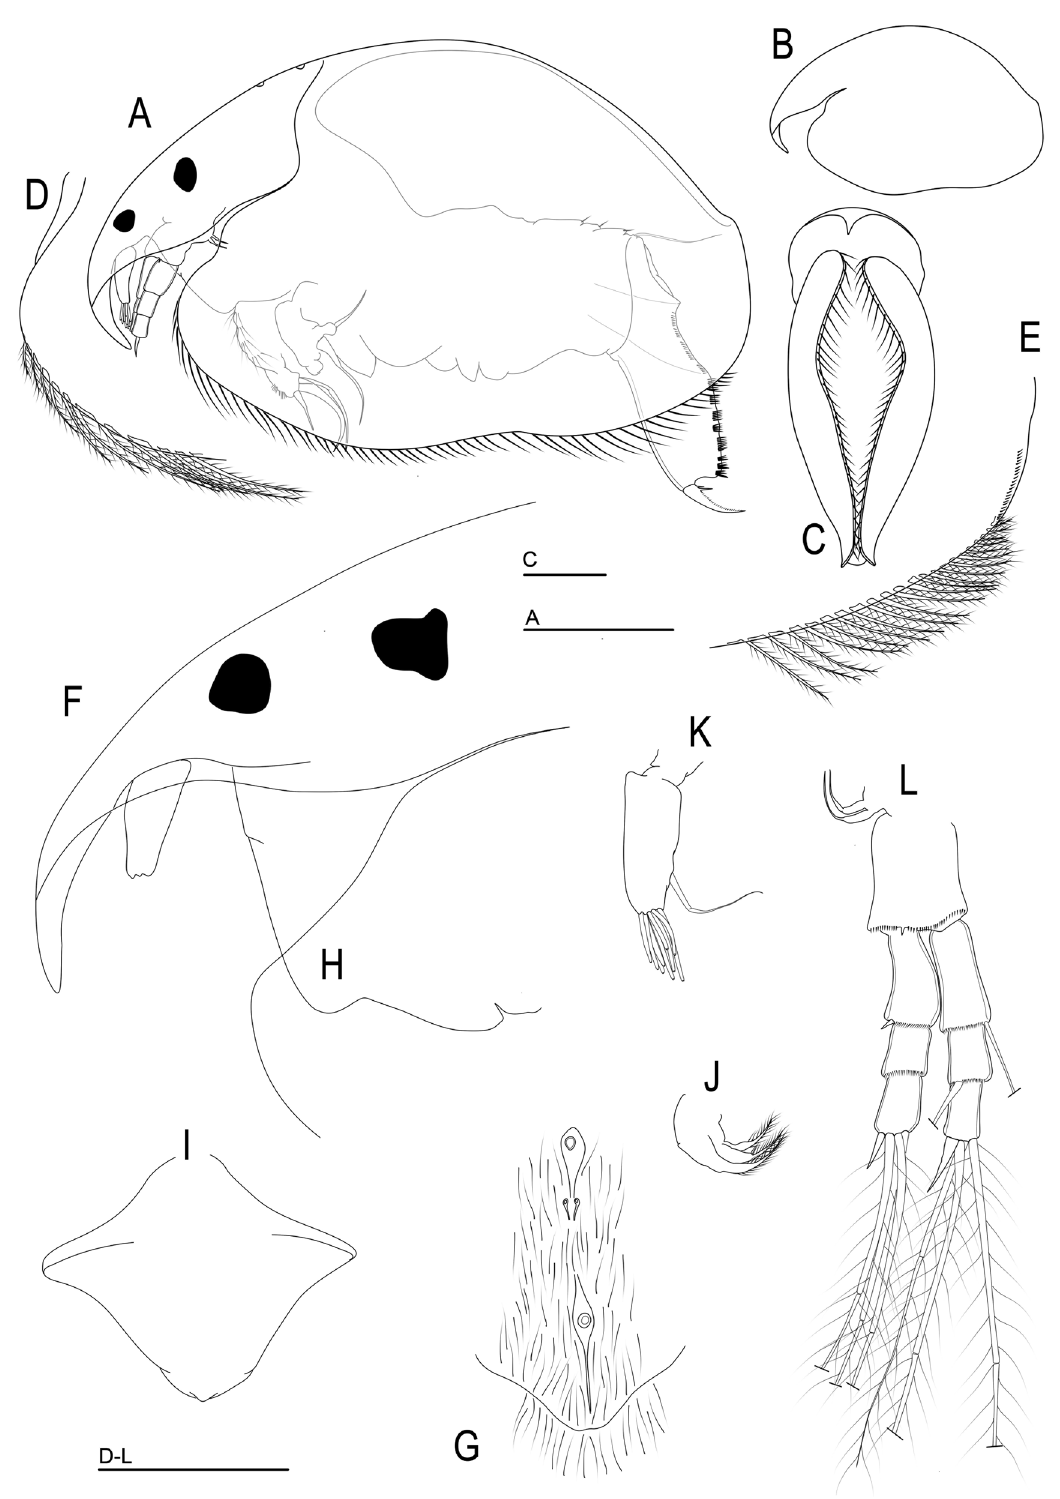
Fig. 10. Disparalona ( Mixopleuroxus ) tenuispina sp. nov., parthenogenetic female. A–B . Habitus. C . Ventral view of carapace. D . Anterior portion of ventral margin of carapace. E . Posterior portion and posteroventral corner of carapace. F . Rostrum. G . Main head pores. H . Labrum. I . Idem , frontal view. J . Maxilla. K . Antennule. L . Antenna. Scale bars: A = 80 μm; C–L = 50 μm. Fig. B was not